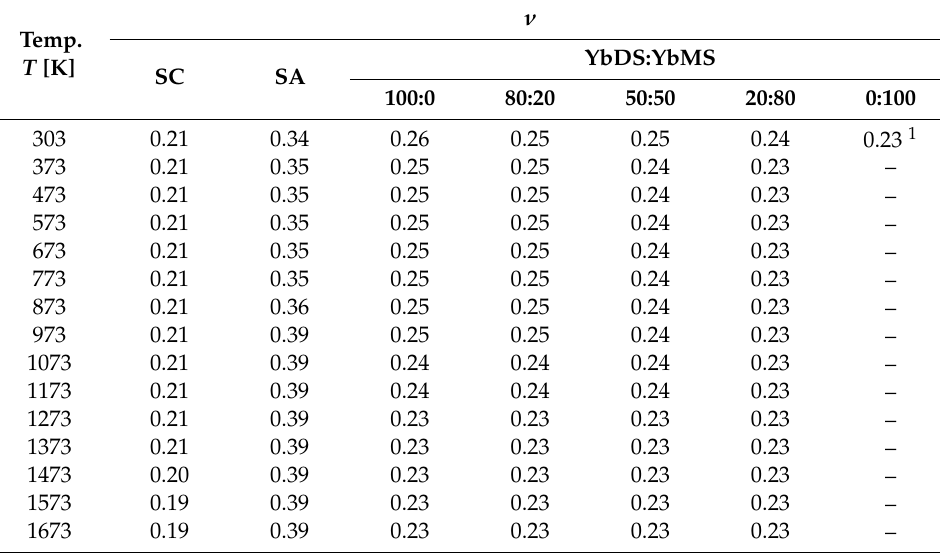
Table 3. Poisson’s ratios ( ν ) of isotropic elastic layers.